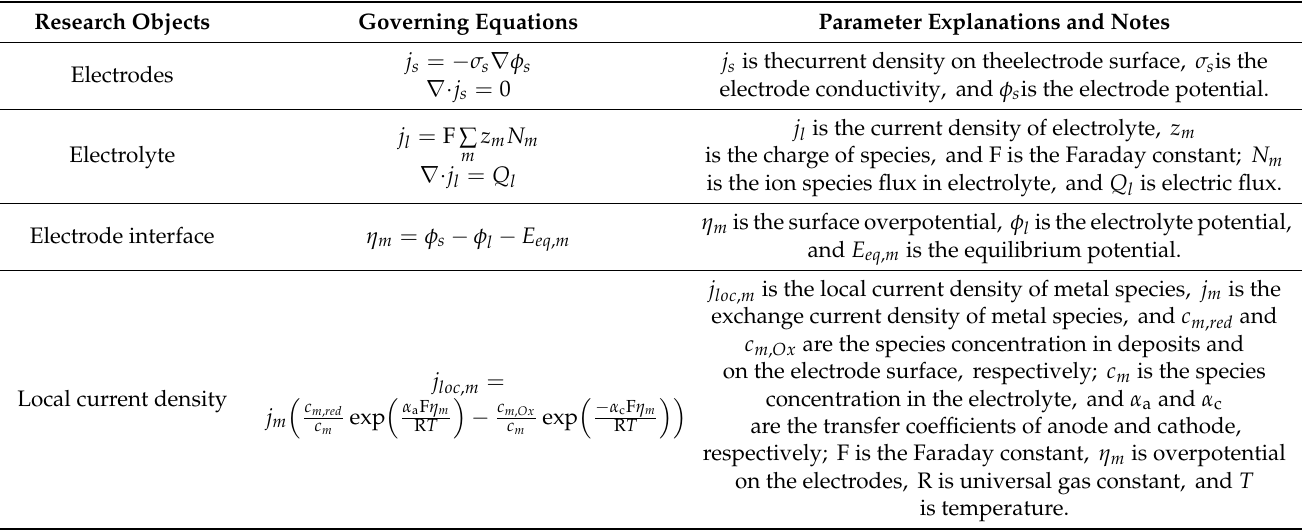
Table 1. Tertiary current distribution-related